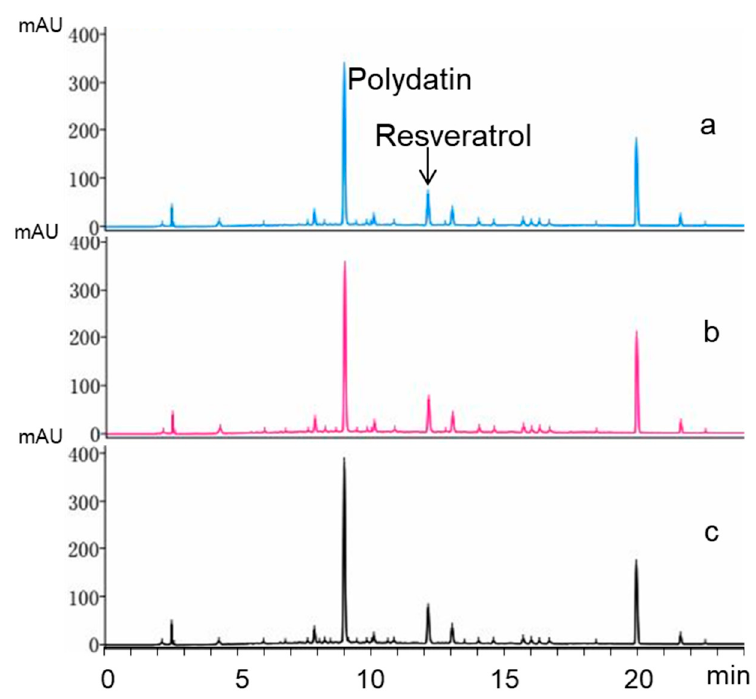
Figure 7. Representative HPLC chromatogram of X1 culture transforming polydatin in crude extract into resveratrol. ( a ): RJE (10 mg / mL); ( b) : RJE (10 mg / mL) + 5% seed culture; ( c ): RJE (10 mg / mL) + X1 culture that grows to a logarithmic stage.